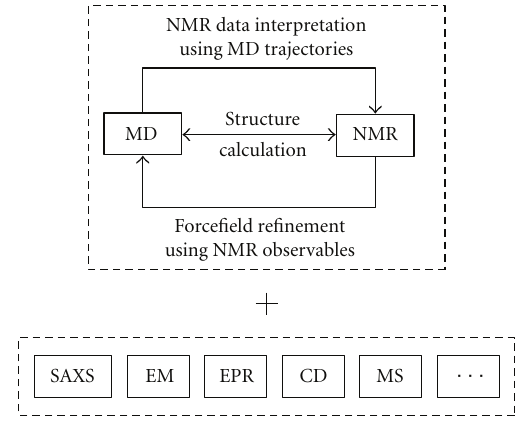
Figure 3: Summary of the relationship between solution NMR spectroscopy and MD simulations, as presented in this paper, along with a listing of other complementary experimental